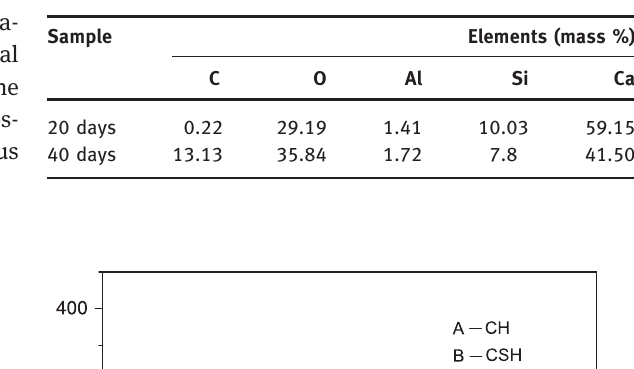
Table 1: Elemental composition in cement near the interface.